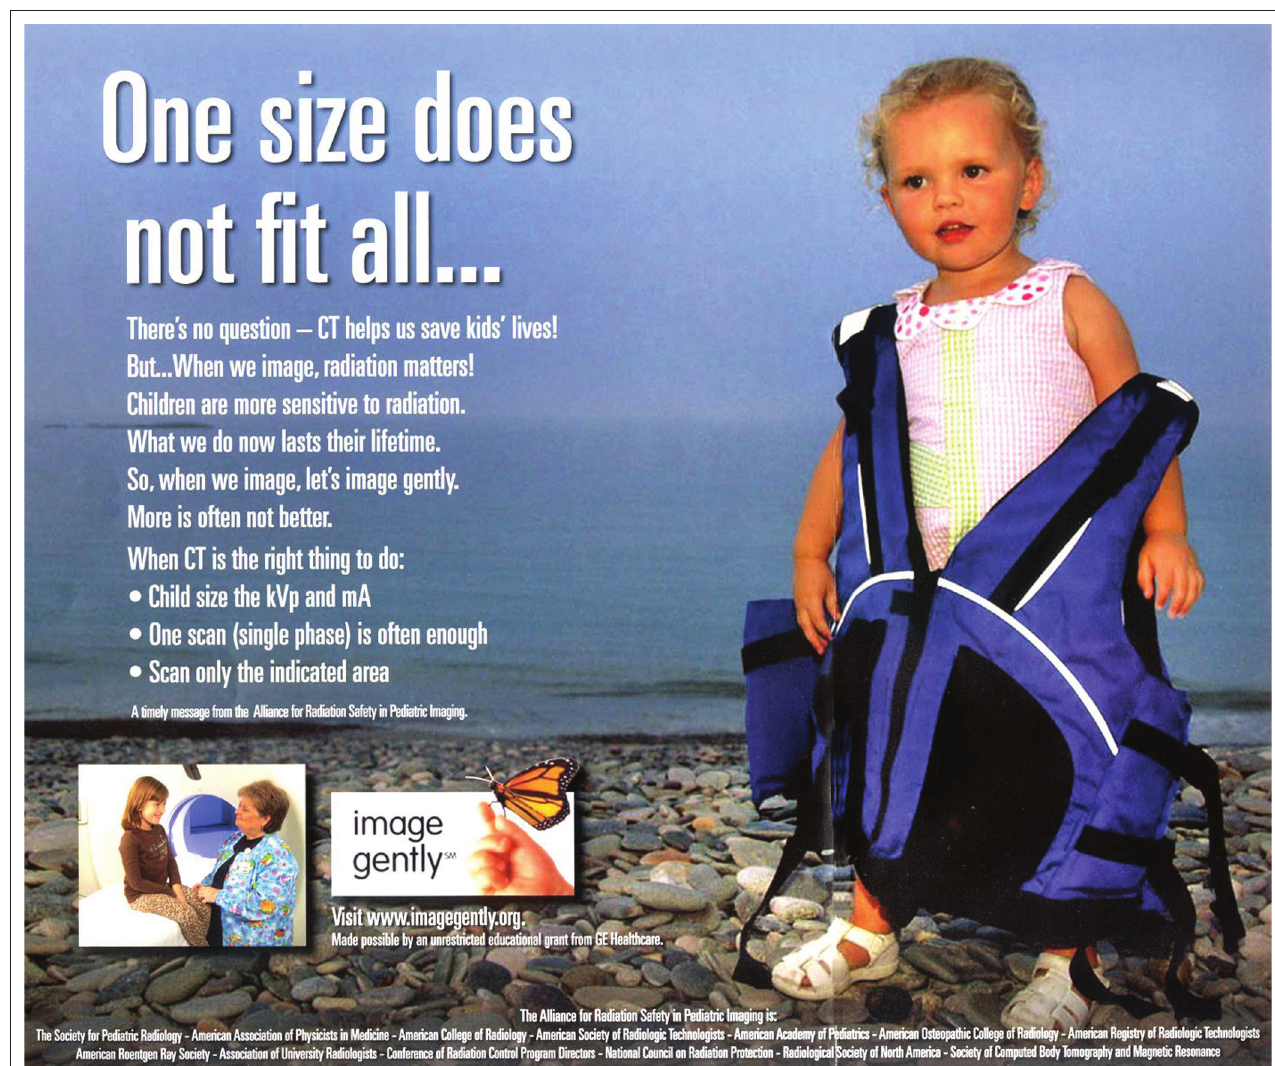
FIGURE 2: The Image Gently campaign’s simple message about CT scanning in children. The photograph of the girl shows her wearing an adult-sized life jacket, which is paired with the message that ’one size does not fit all’. For safety reasons, we would not put an adult life jacket on a child; equally, we should not perform an imaging test on a child using an adult level of ionising radiation. (Reprint permission granted by the Image Gently